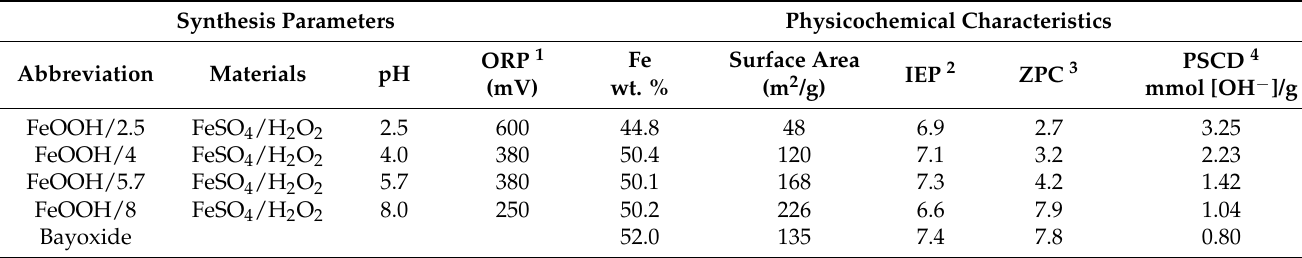
Table 2. The main physicochemical characteristics of laboratory-synthesized and commercial adsorbents based on FeOOHs and used in this study for the separation of selenium